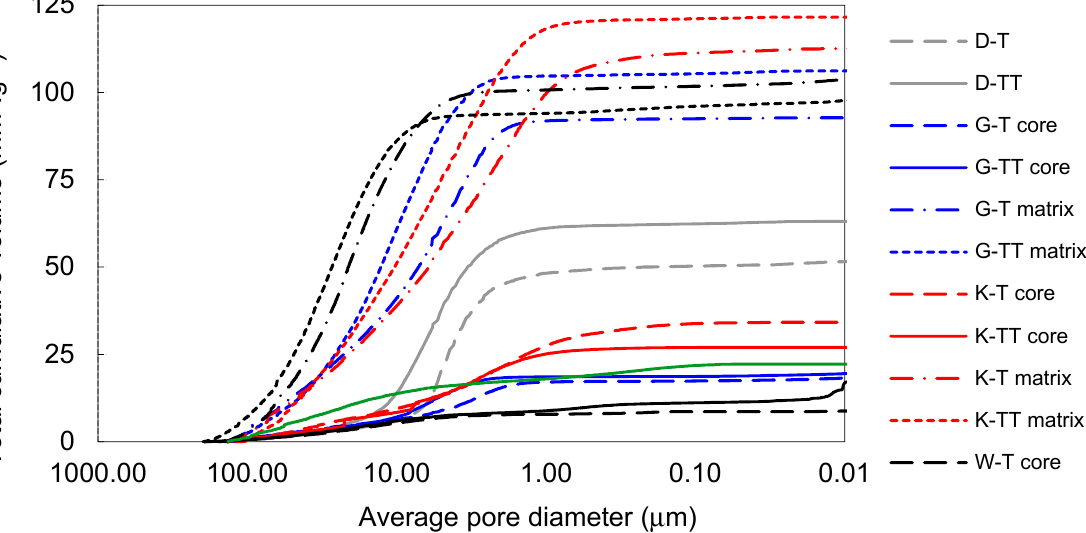
Figure 7. Total cumulative pore volume of samples prepared by pilot industrial tests and the reference material.